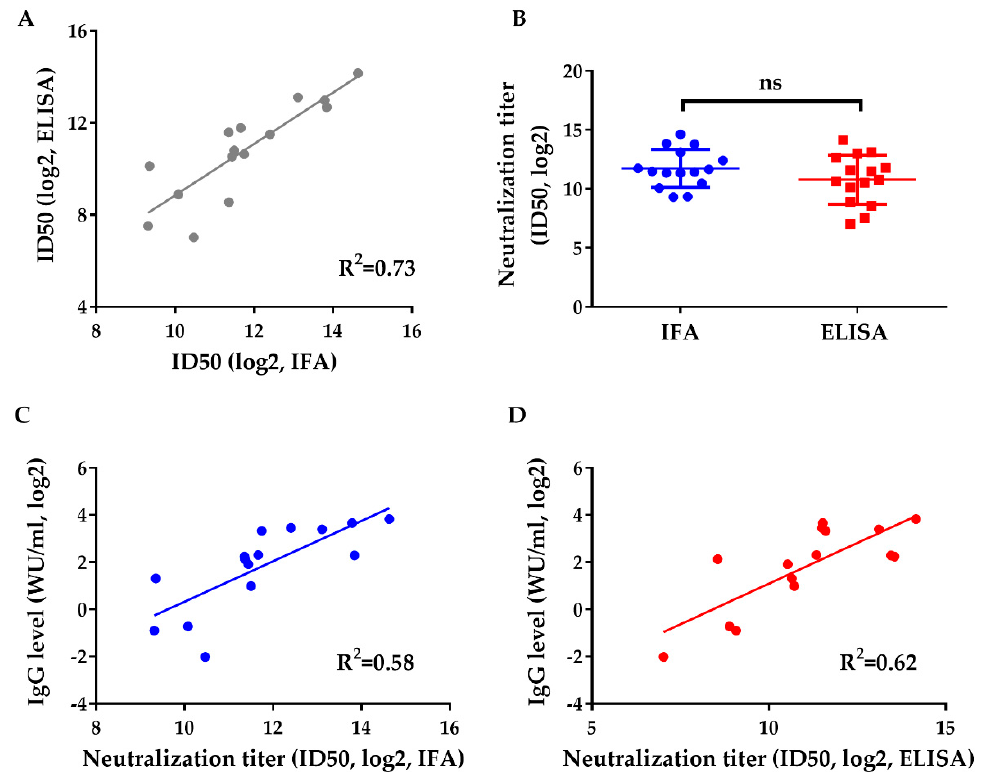
Figure 3. Neutralization test of sera of vaccinated subjects evaluated by IFA and ELISA and the relationship between neutralization titer and IgG level. The neutralizing capacities against the Kernow of vaccinated human sera ( n = 15) were measured by IFA and ELISA. The IgG levels of human sera were all above the 0.077 WU per milliliter. ( A ) Correlation of the neutralization titers measured by IFA and ELISA. ( B ) Comparison of the neutralization titers measured by IFA and ELISA using a paired t -test. Two-sided p -values are given; “ns” indicates that there were no significant differences. ( C ) Correlation analysis between IgG level and the neutralization titer detected by IFA. ( D ) Correlation analysis between IgG level and the neutralization titer detected by ELISA. The neutralization titers of the sera were calculated with 50% inhibitory dilutions (ID50 values). The results were log2-transformed.